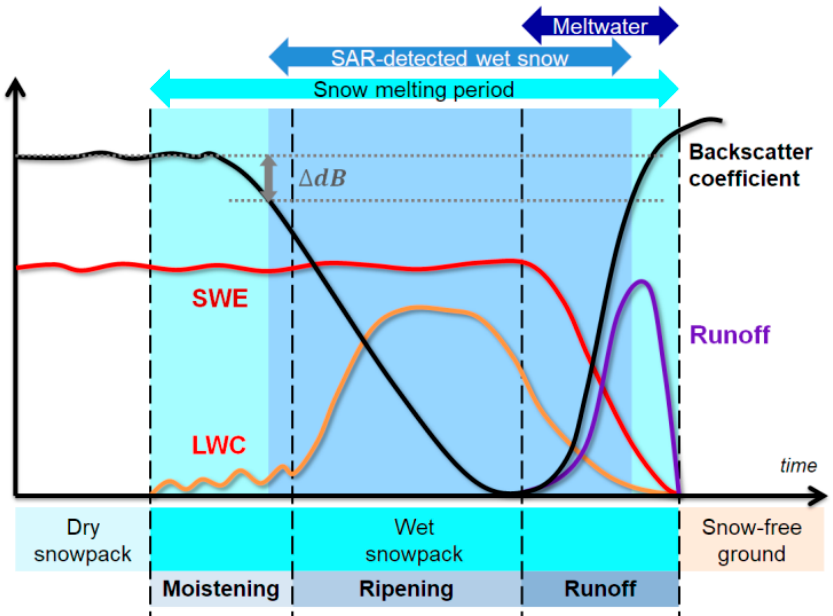
Figure 17. The relationship of SAR-based wet snow detection and the snowmelt processing (modified from [11]). The amount of liquid water content (LWC), snow water-equivalent (SWE), and the released snowmelt runoff together with the SAR signal backscatter coefficient in different snowmelt phases are illustrated.